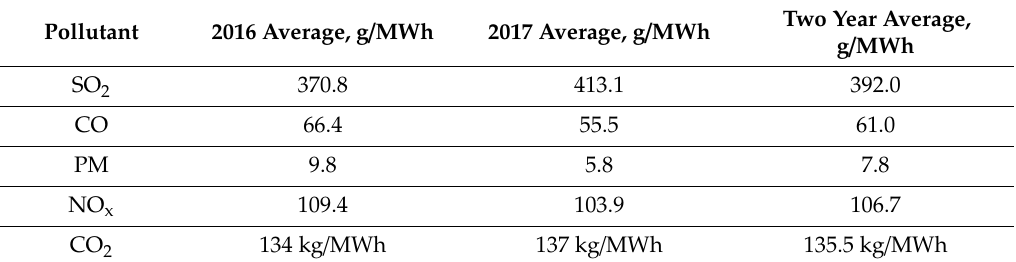
Table 8. Specific emissions from electric energy production, s em,el , produced by Slovensk é elektr á rne, a.s. and related to the net electric energy delivery to the grid